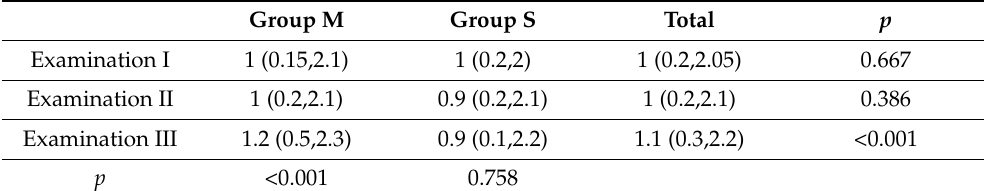
Table 4. Statistical analysis of both the intra- and the intergroup median PTV differences between all